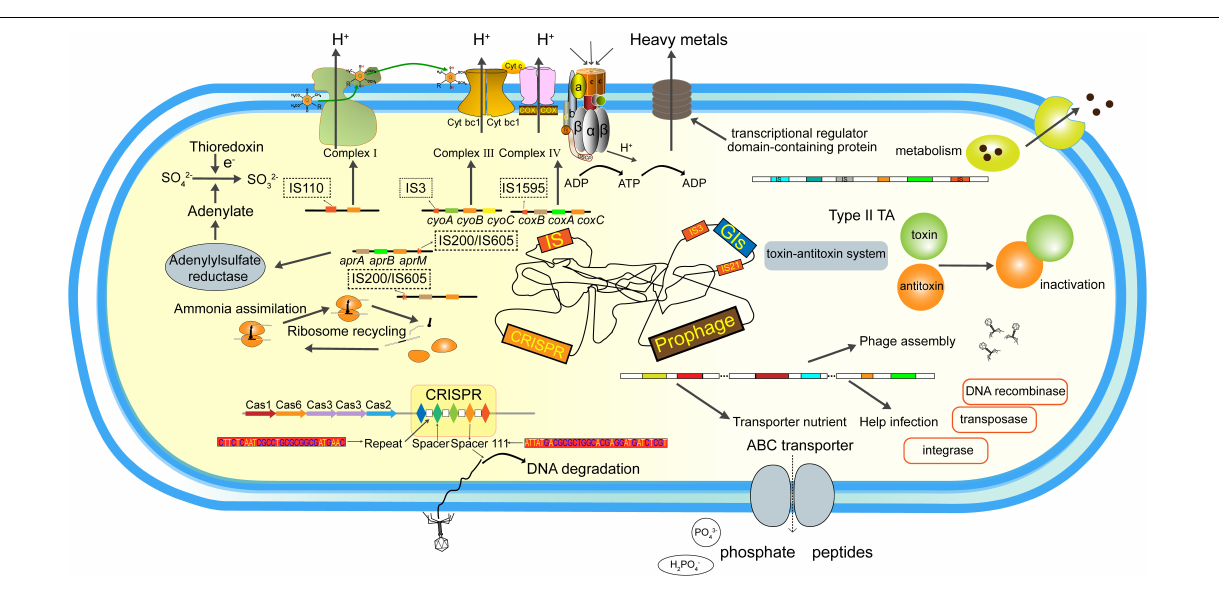
FIGURE 8 | Functional repertoires of the Af. thiooxydans ZJ. The MGEs and their predicted gene products identified in this